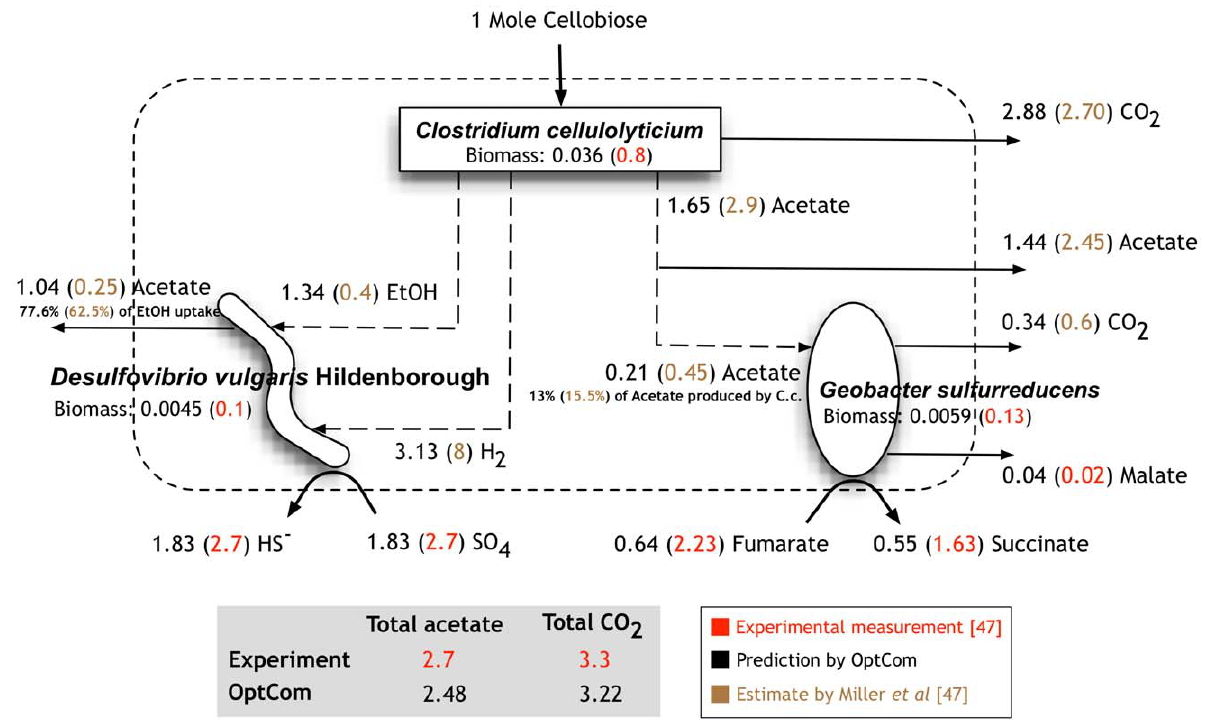
Figure 5. Comparison of the predicted fluxes by OptCom with estimates in the proposed model of [ 47 ] . The total predicted acetate and CO 2 production rates by OptCom are in good agreement with experimental measurements by Miller et al [47]. Note that it was not possible to determine experimentally how much of the total acetate or CO 2 available in the supernatant of the bioreactor is produced by which microorganism (the values provided by Miller et al [47] for the acetate and CO 2 production by each species as well as all inter-organism flow rates are estimates and not experimental measurements). The values associated with the biomass of each microorganism represent fluxes (1/h) for OptCom predictions and concentrations (M) for experimental measurements [47].